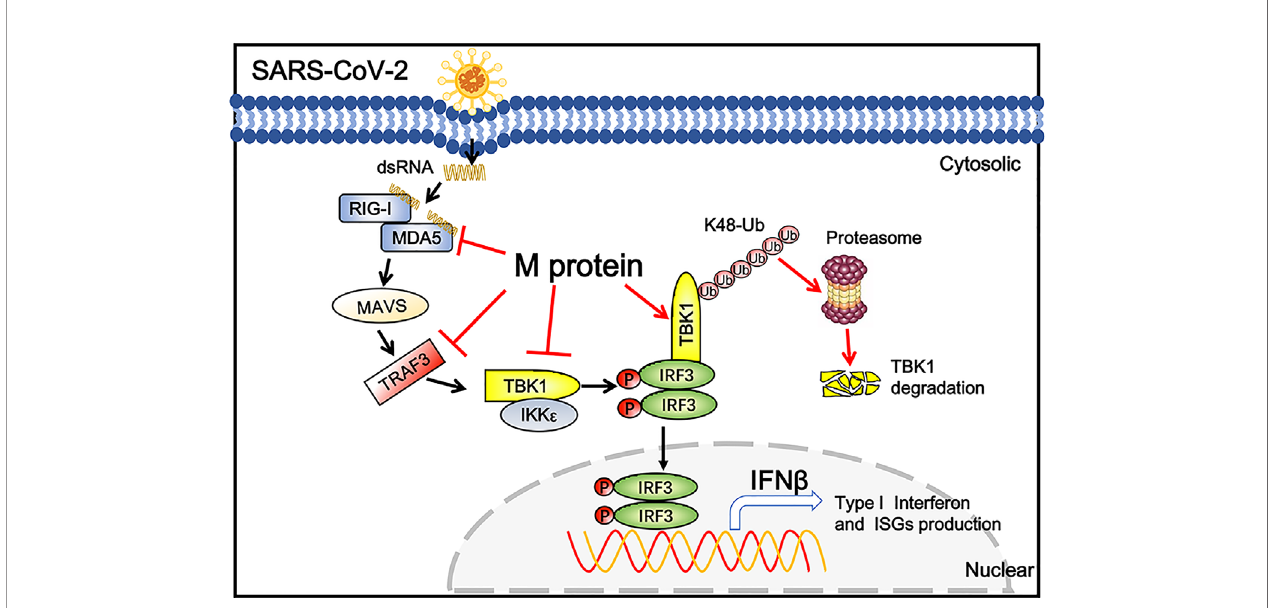
FIGURE 6 | Schematic diagram of SARS-CoV-2 M inhibiting IFN-I signaling. M protein interacts with MDA5, TRAF3, TBK1, IKK ϵ and degrade TBK1 via K48-linked ubiquitination, which suppresses the phosphorylation and nuclear translocation of IRF3 and blocks IFN